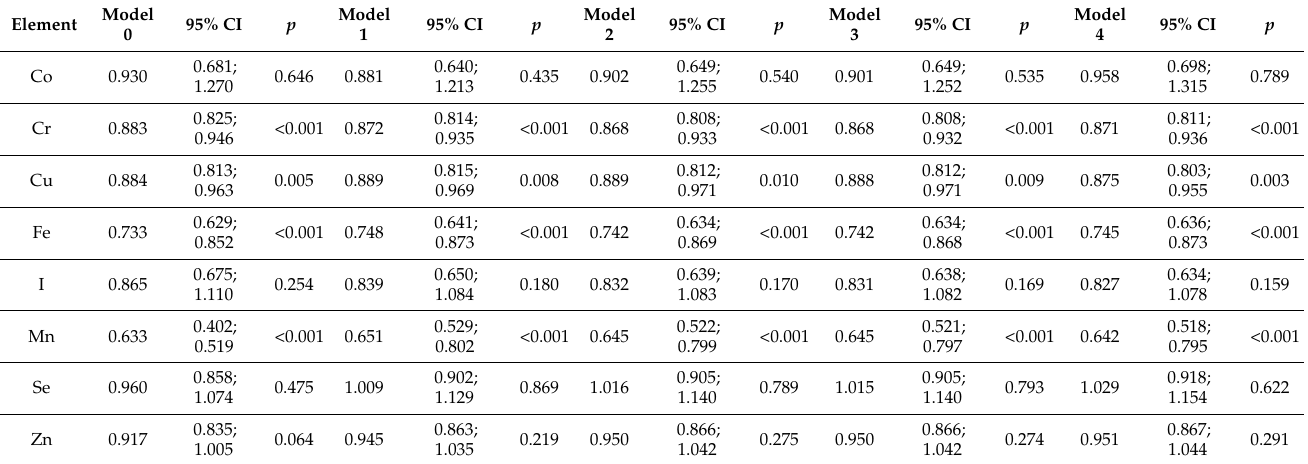
Table 3. Assessment of crude and adjusted differences in essential trace element content of hair: results of multiple regression